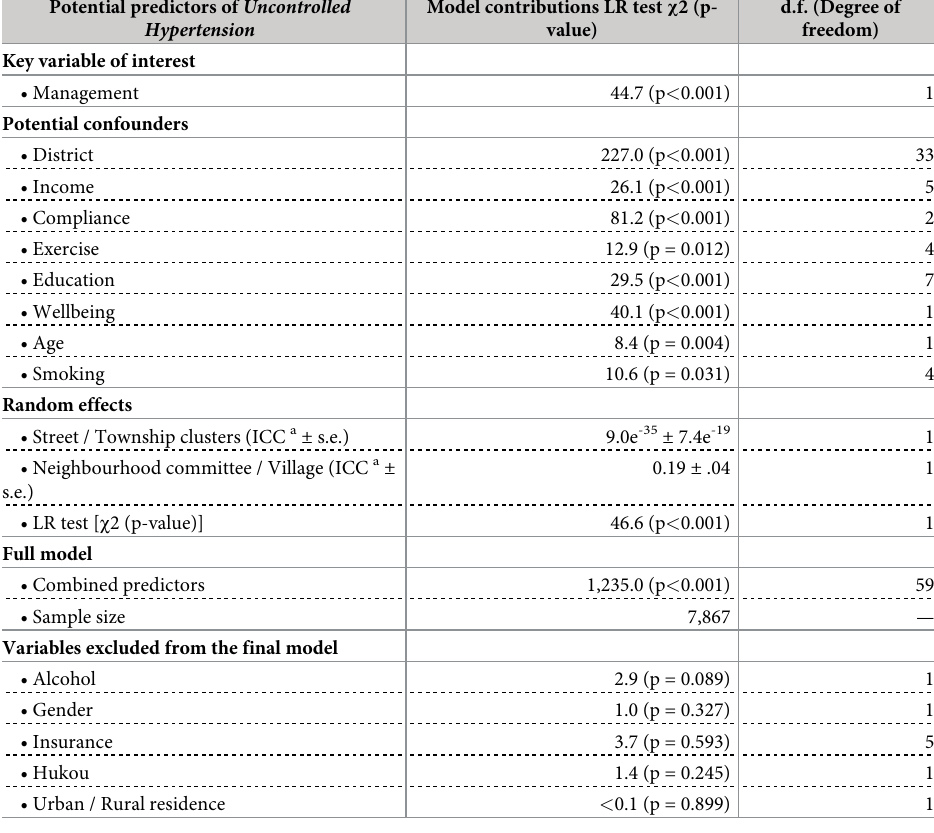
Table 4. Selection of variables for inclusion in multi-variable mixed logit regression models designed to test the association between Management and Uncontrolled Hypertension